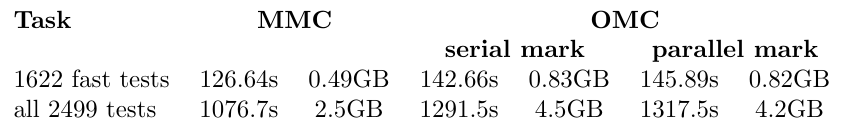
Table 5: Compiler performance, OpenModelica testsuite, run in parallel.